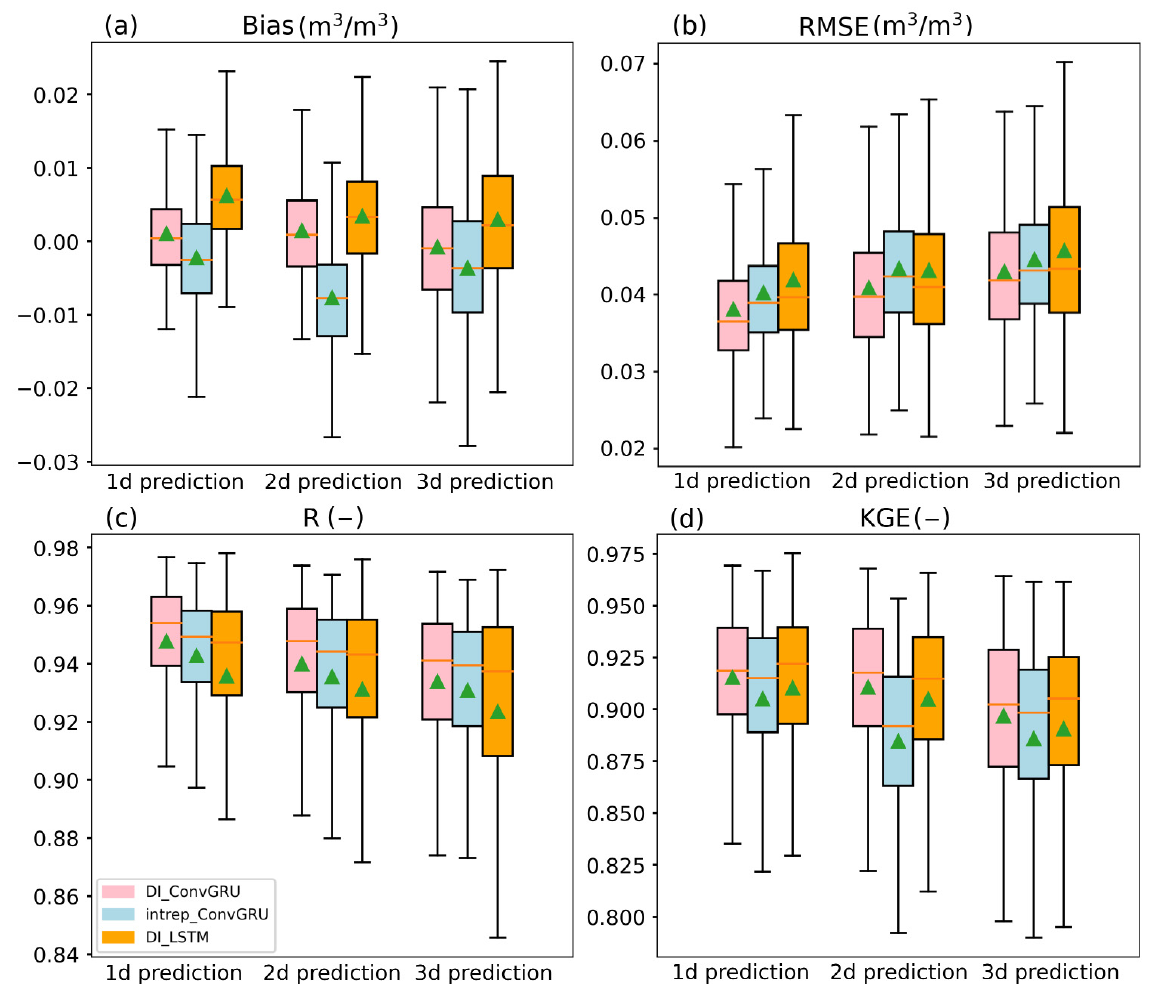
Figure 5. Box plots of the Bias ( a ), RMSE ( b ), R ( c ) and KGE ( d ) of comparison between SMAP L3 SM and predicted values of DI_ConvGRU, interp_ConvGRU and DI_LSTM. The green triangles represents the mean of the corresponding box plot.